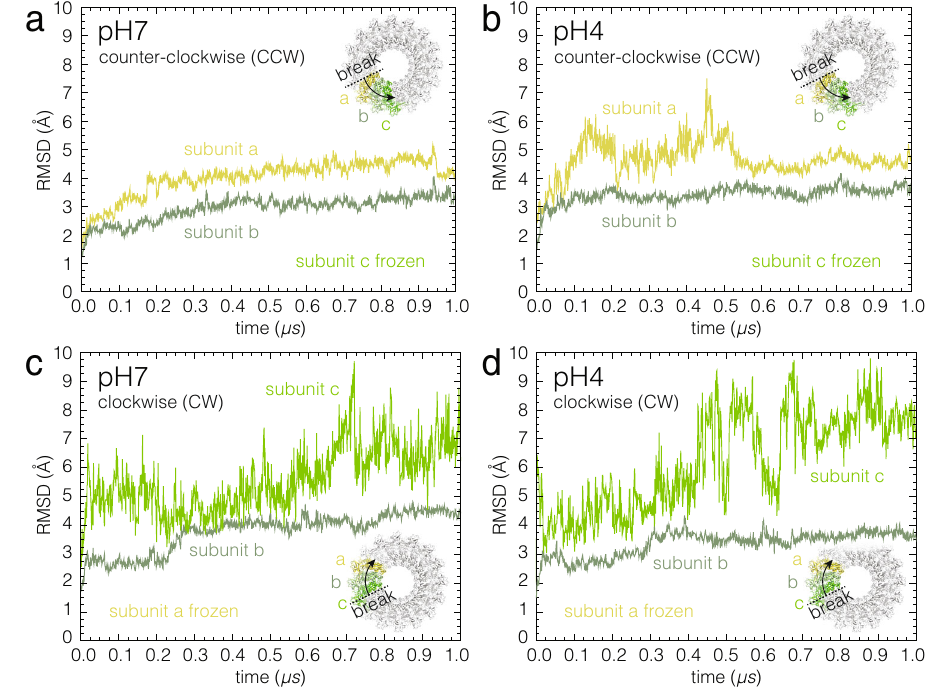
Fig. 3 | Structural fl uctuations of the free subunits upon pre-pore ring break- age. Comparison of the backbone atom distance root-mean-square deviations (RMSDs) of the CCW (subunit-a, a , b ) and the CW (subunit-c, c , d ) subunits with